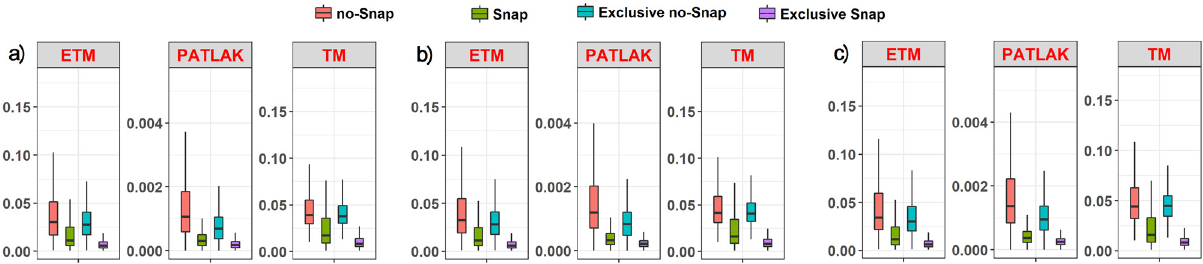
Figure 2: k trans ( min − 1 ) boxplots for di ff erent values of adj - R 2 thresholding: ( a ) 0.2 threshold, ( b ) 0.3 threshold, and ( c ) 0.4 threshold for the NoSnaps and Snaps protocols; pixels exclusively characterized by NoSnaps and pixels exclusively characterized by Snaps.